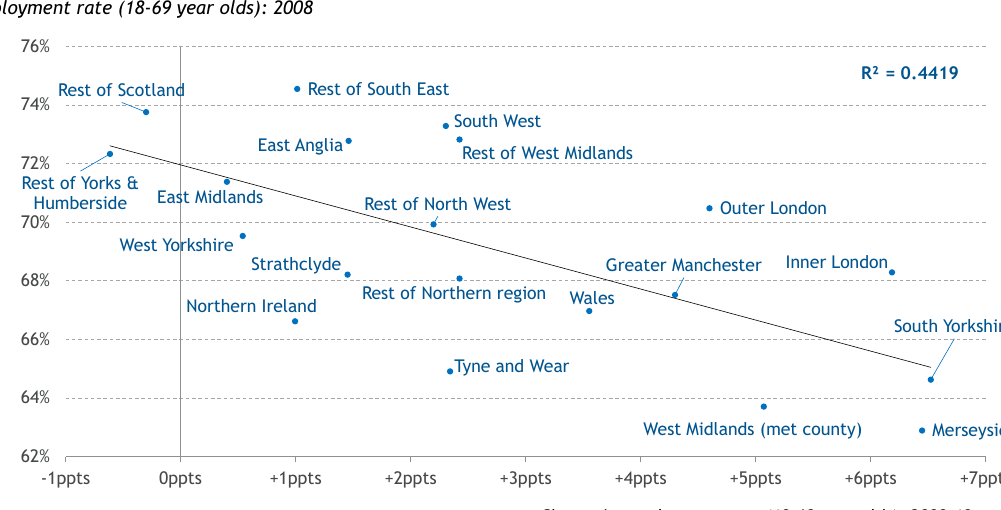
Figure 17: Places with low employment rates tended to see sharper increases in their employment rate over the past